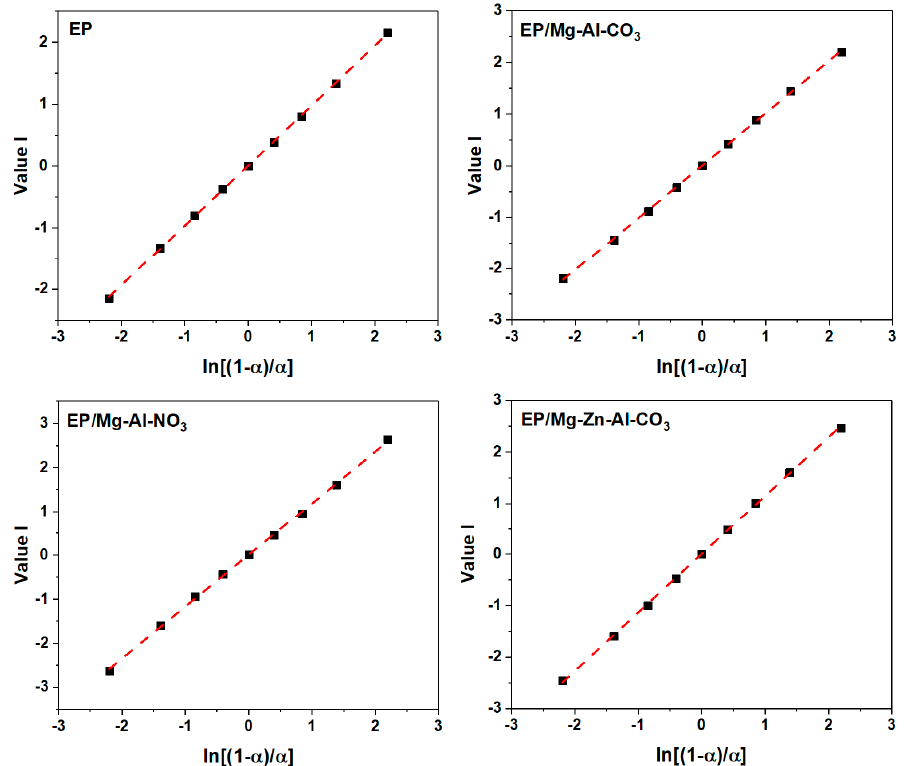
Figure A6. Plots of value I calculated using DSC data for the prepared epoxy system under a heating rate of 2 °C ∙ min − 1 .